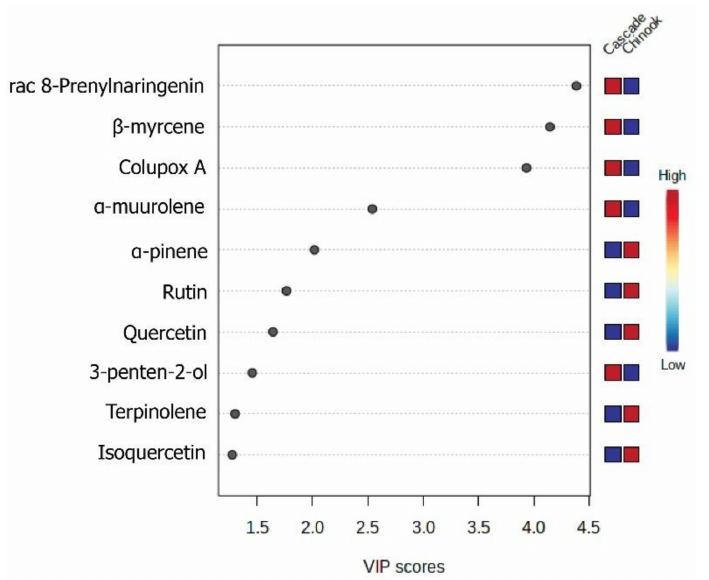
Figure 7. PLS-DA and variable importance in projection (VIP) plot. It displays the top 10 most important metabolite features identified by PLS-DA. Colored boxes on the right indicate the rel- ative mean percentage of the corresponding metabolite for H. lupulus inflorescences. VIP is a weighted sum of squares of the PLS-DA loadings considering the amount of explained Y-variable in each